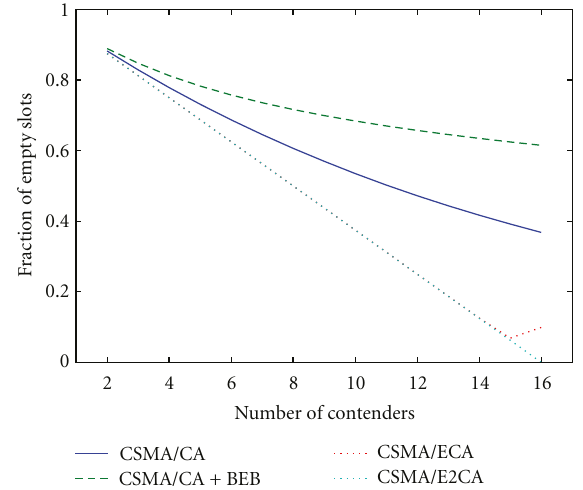
Figure 5: Fraction of empty slots for each of the three protocols under comparison for di ff erent number of